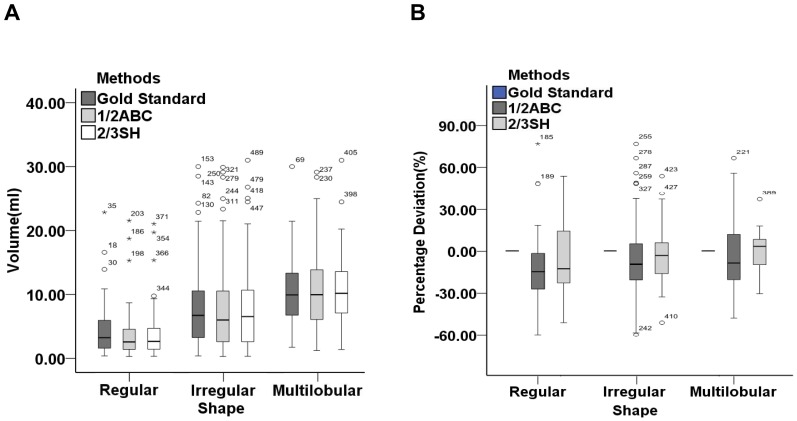
Hematoma volumes (ml) and percentage deviations (%) for regular, irregular and multilobular hemorrhages calculated by gold standard, formula 1/2ABC and 2/3SH.(A) the comparison of three methods in hematoma volume was statistically indistinguishable (P>0.05); (B) formula 1/2ABC and 2/3SH underestimated hematoma volume by −18.51(−28.20, −5.80)% and −15.56(−25.85, 3.38)% for regular hemorrhage, −9.26(−20.75, 5.19)% and −3.23(−15.78, 6.17)% for irregular hemorrhage, respectively. However, for the multilobular shaped hemorrhage, the formula 1/2ABC underestimated by −8.53(−16.73, 4.25)% and 2/3SH overestimated only by 1.96(−6.37, 9.68)%.